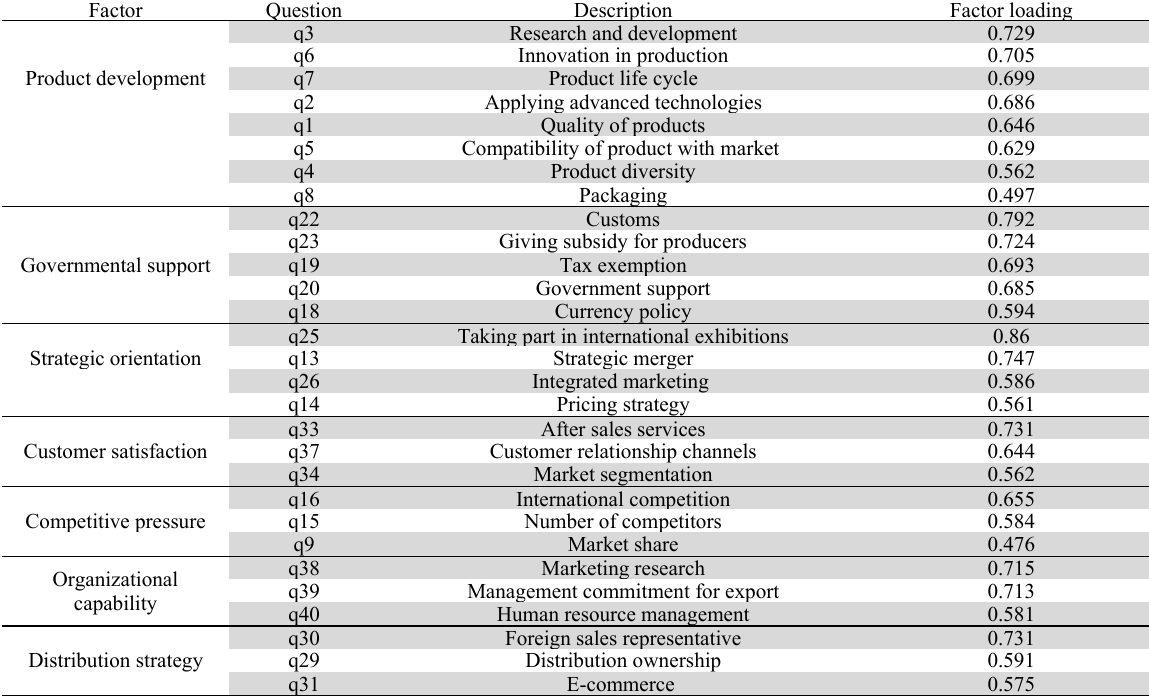
The summary of factors and their components